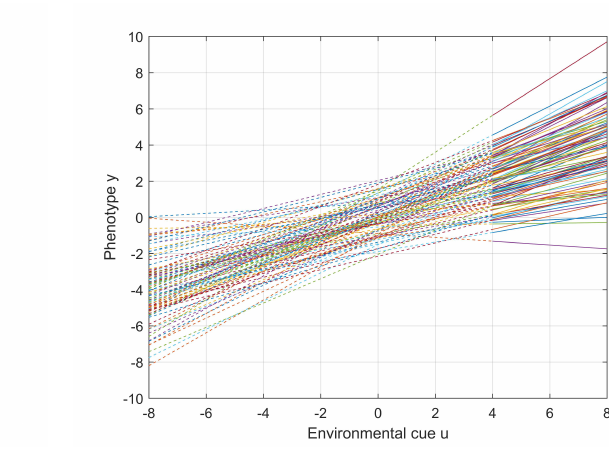
Figure 2: Reaction norms for 100 individuals with reac- tion norms according to y = a + b ( u − c )+ e , with ¯ a = ¯ c = ¯ e = 0 and ¯ b = 0 . 5. The traits a , b and c , and the residual e , are inde- pendent and normally distributed, with vari- ances G aa = 0 . 5, G bb = 0 . 045, G cc = 0 . 5, = 0 . 5, respectively. and σ 2 e